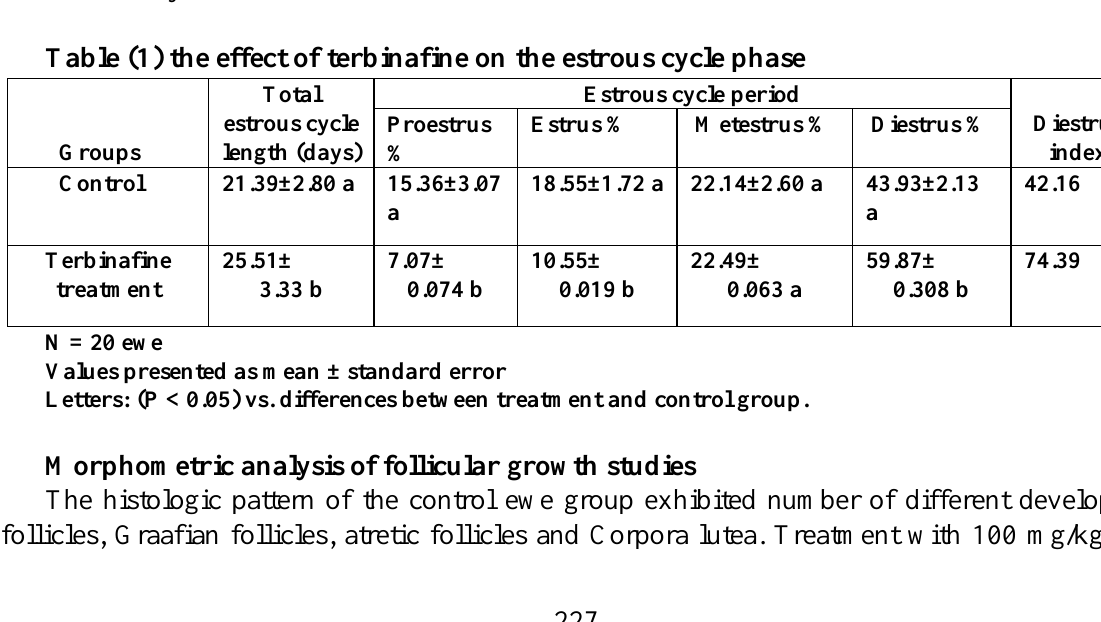
Table (1) the effect of terbinafine on the estrous cycle phase